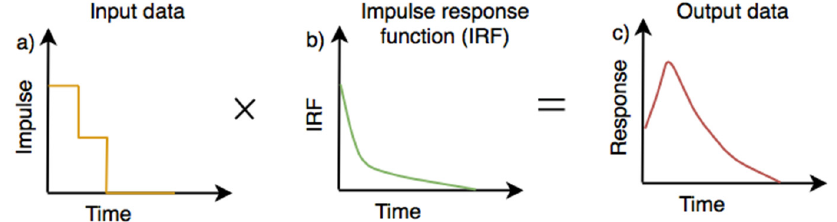
Figure 2. Conversion of input data using impulse response function ( IRF) , adapted from Shimako [7].